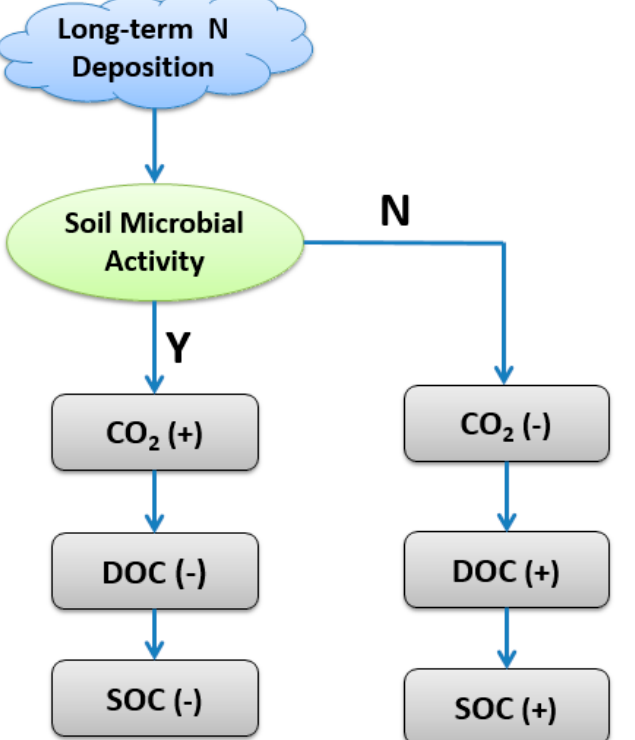
Figure 2. A conceptual model on how long-term N deposition affects soil C soil mineralization and storage through altering soil microbial activity in both microbial biomass and community